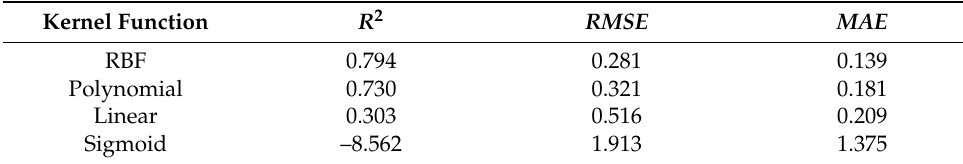
Table 2. Statistical indicators of the results calculated by SVR models. Kernel Function